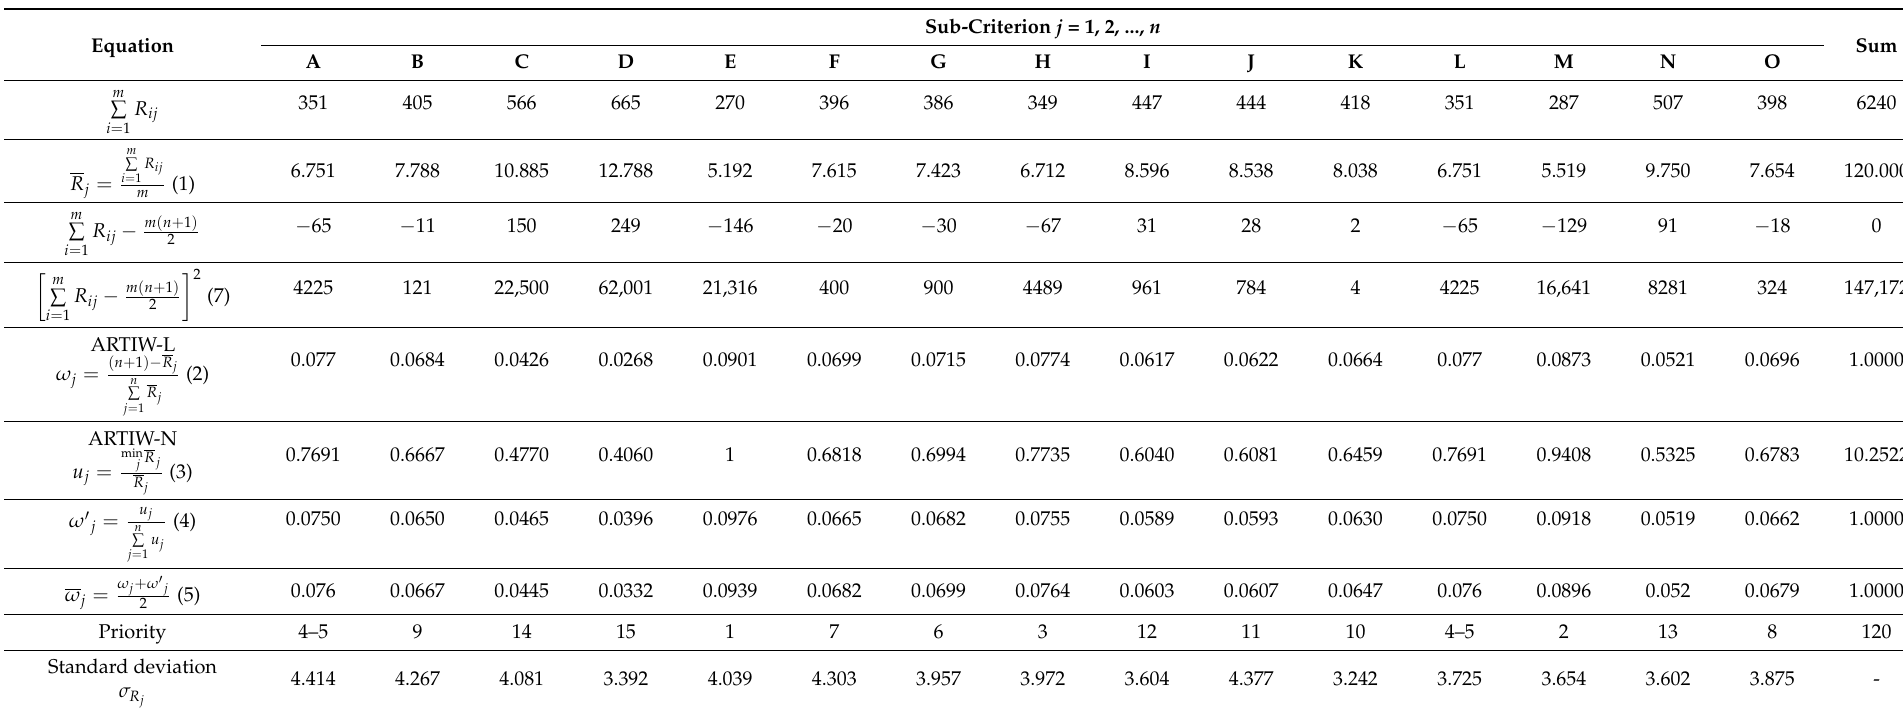
Table 2. Averages of sub-criteria ranks R j of passenger choice to travel by train as an alternative to travel by bus and calculated weights ω j and ω (cid:48) j with reference to linear ARTIW-L and non-linear ARTIW-N methods (model Figure